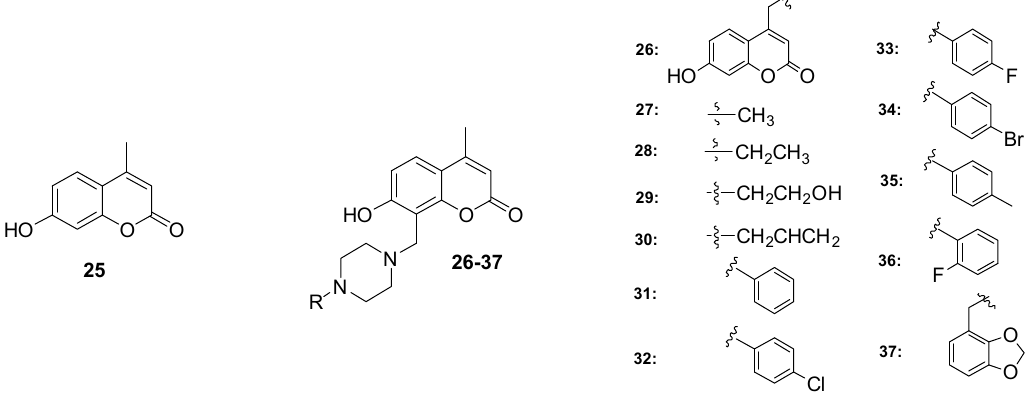
Figure 14. Chemical structure of compound 25 and piperazine derivatives 26–37 .